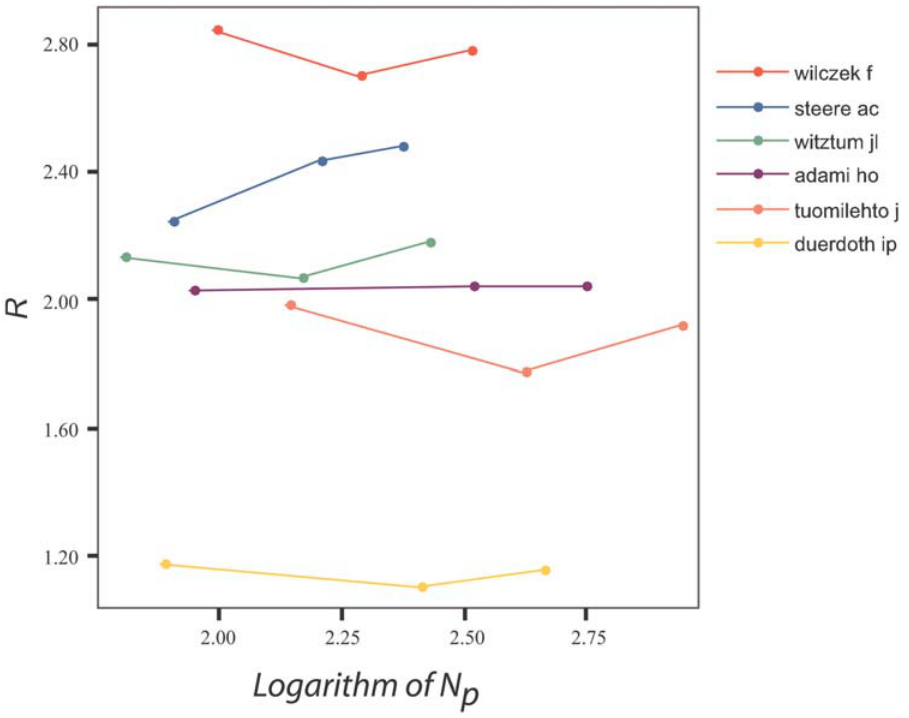
Figure 3. Evolution of R over time as function of the number of papers N p for selected scientists with different networking profiles.